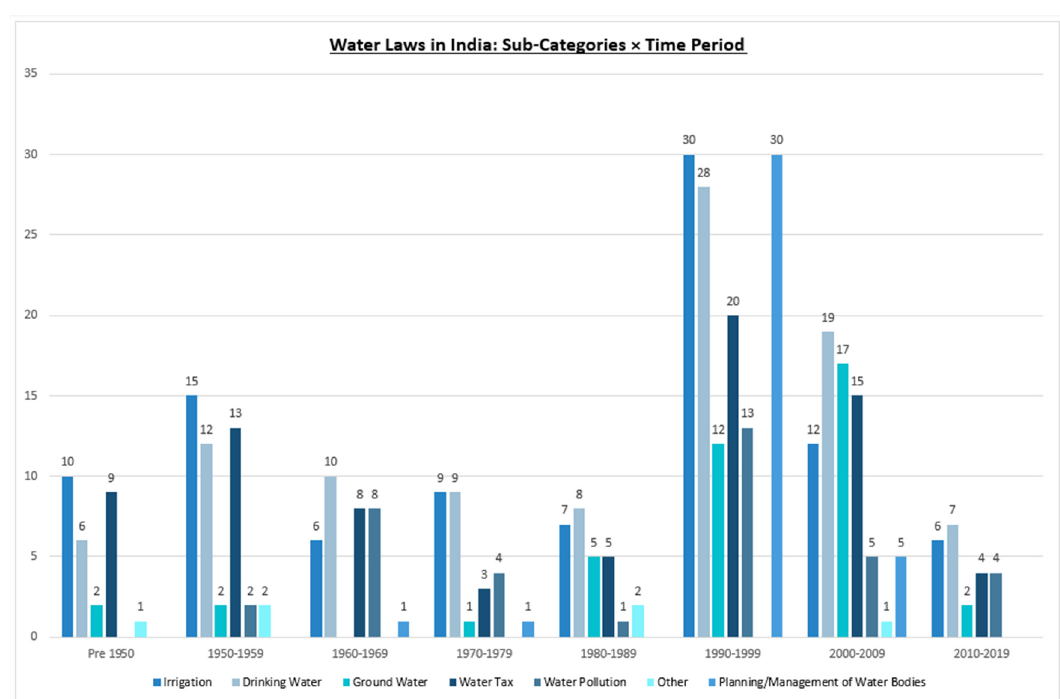
Figure 3. Timeline distribution of different categories of water laws in India .